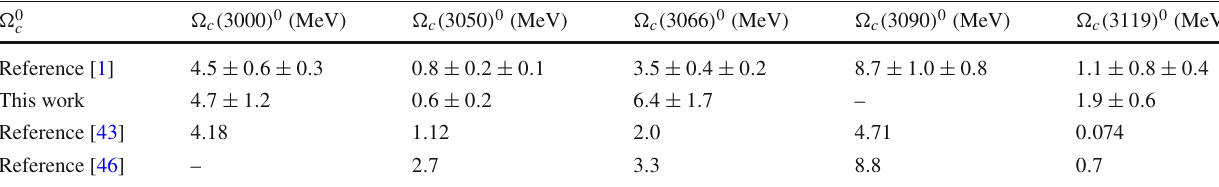
Table 4 The theoretical predictions and experimental data for the widths of the (cid:2) 0 c